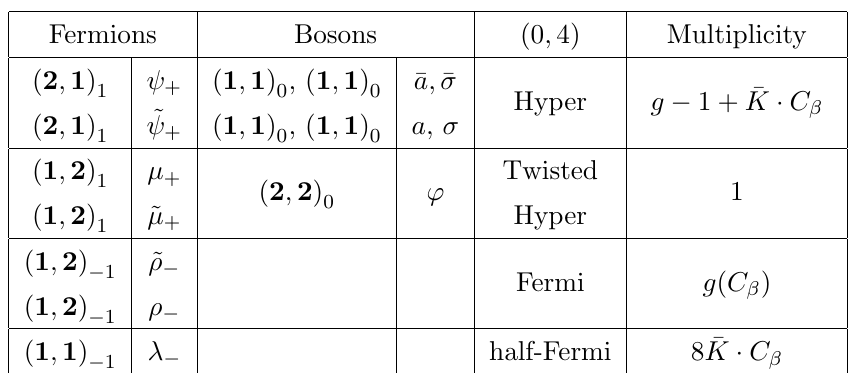
Table 1 . Spectrum of massless 2d N = (0 ; 4) multiplets of the e(cid:11)ective world-sheet theory of the string that arises from a D3-brane that wraps C (cid:12) (cid:26) B 2 (not contained in the discriminant). The representations are under SU(2) + (cid:2) SU(2) (cid:0) (cid:2) SO(1 ; 1). The table is a modi(cid:12)cation of table 3 in [42].